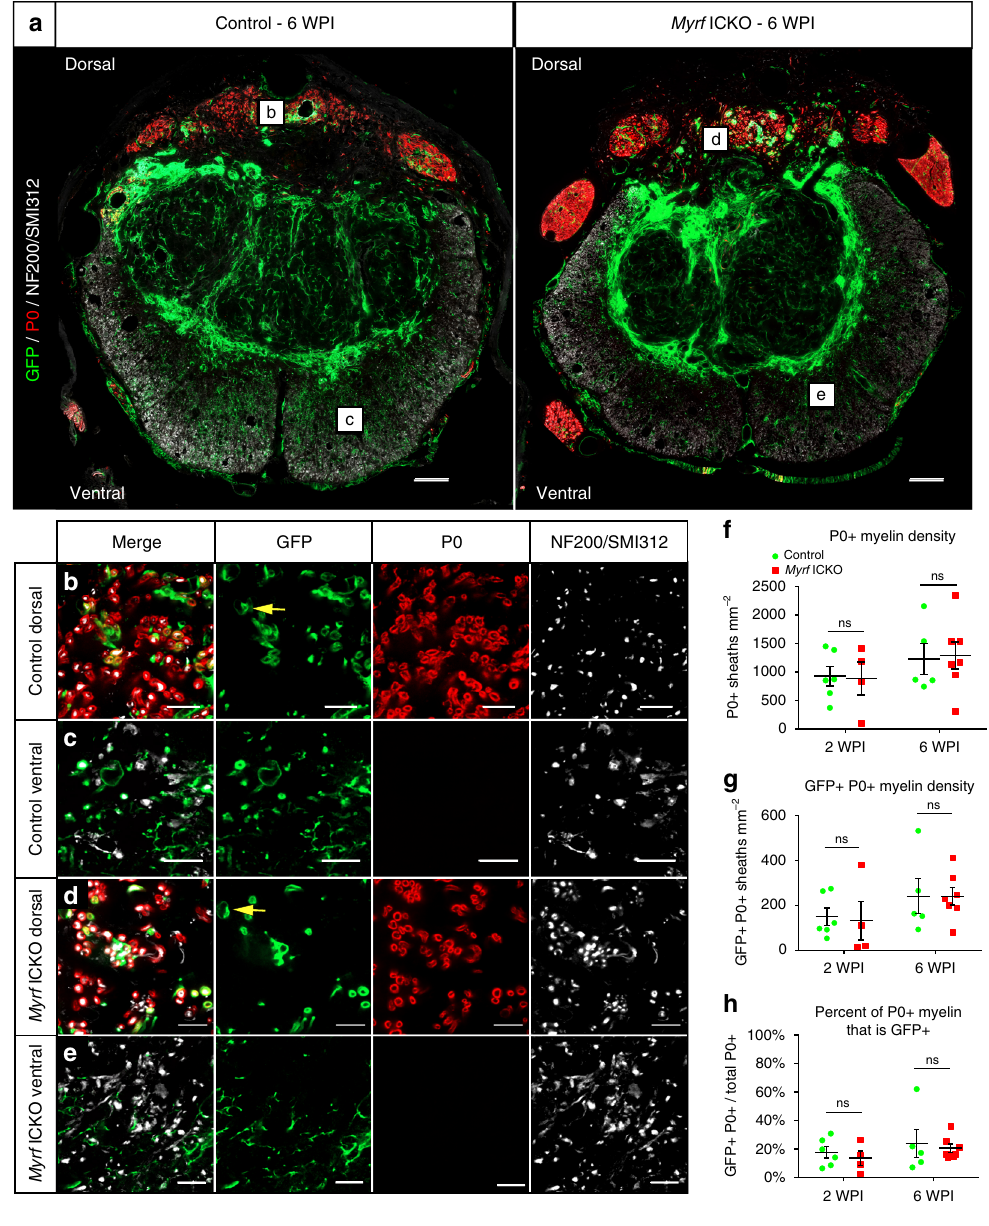
Fig. 4 Myrf ICKO does not alter Schwann cell myelination following SCI. a Overview images of spinal cord cross sections from control mT/mG and Myrf ICKO mT/mG mice stained with GFP, the Schwann cell myelin marker P0 and NF-200/SMI312 to label axons. In both Myrf ICKO and controls, P0 + staining is mostly con fi ned to the dorsal column. b – e Single optical confocal micrographs in either the dorsal or ventral white matter of control and Myrf ICKO mice with the mT/mG reporter. In the dorsal column of control and Myrf ICKO mice there are P0 + sheaths around NF200/SMI312 + axons, some of which colabel with GFP. There are typically very few P0 + sheaths in either the ventral white matter of control or Myrf ICKO mice. f Quanti fi cation of the total density of P0 myelin sheaths (P0 + ) demonstrates there is no difference between groups at two WPI ( df = 8, t = 0.128, P = 0.901, Student ’ s t test) or at six WPI ( df = 10, t = 0.154, P = 0.880, Student ’ s t test). g Quanti fi cation of the density of newly generated P0 myelin sheaths (P0 + mGFP + ) demonstrates there is no difference between groups at two WPI ( df = 8, t = 0.218, P = 0.883, Student ’ s t test) or at six WPI ( df = 10, t = 0.001, P = 0.999. Student ’ s t test). h The percentage of P0 + myelin sheaths, which are derived from PDGFR α + cells relative to the total P0 + myelin sheaths do not differ between knockouts and controls at two WPI ( df = 8, t = 0.621, P = 0.552. Student ’ s t test) or at six WPI ( df = 10, t = 0.364, P = 0.724, Student ’ s t test). ns = non-signi fi cant. Scale bar = 100 µ m ( a ), 10 µ m ( b – e ). Error bars are mean ±